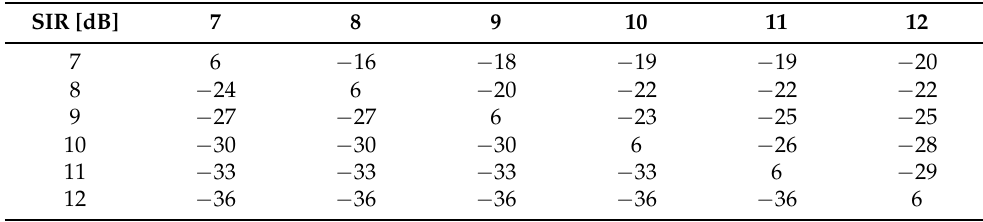
Table 2. SIR margins